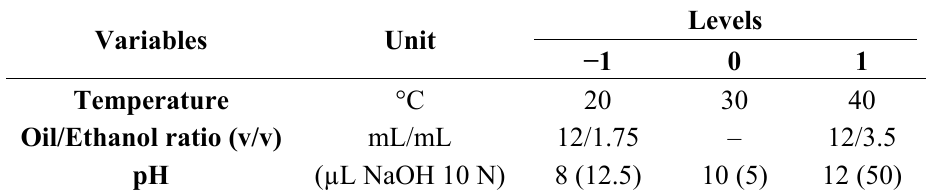
Table 1. Process parameters in factorial design: coded and actual